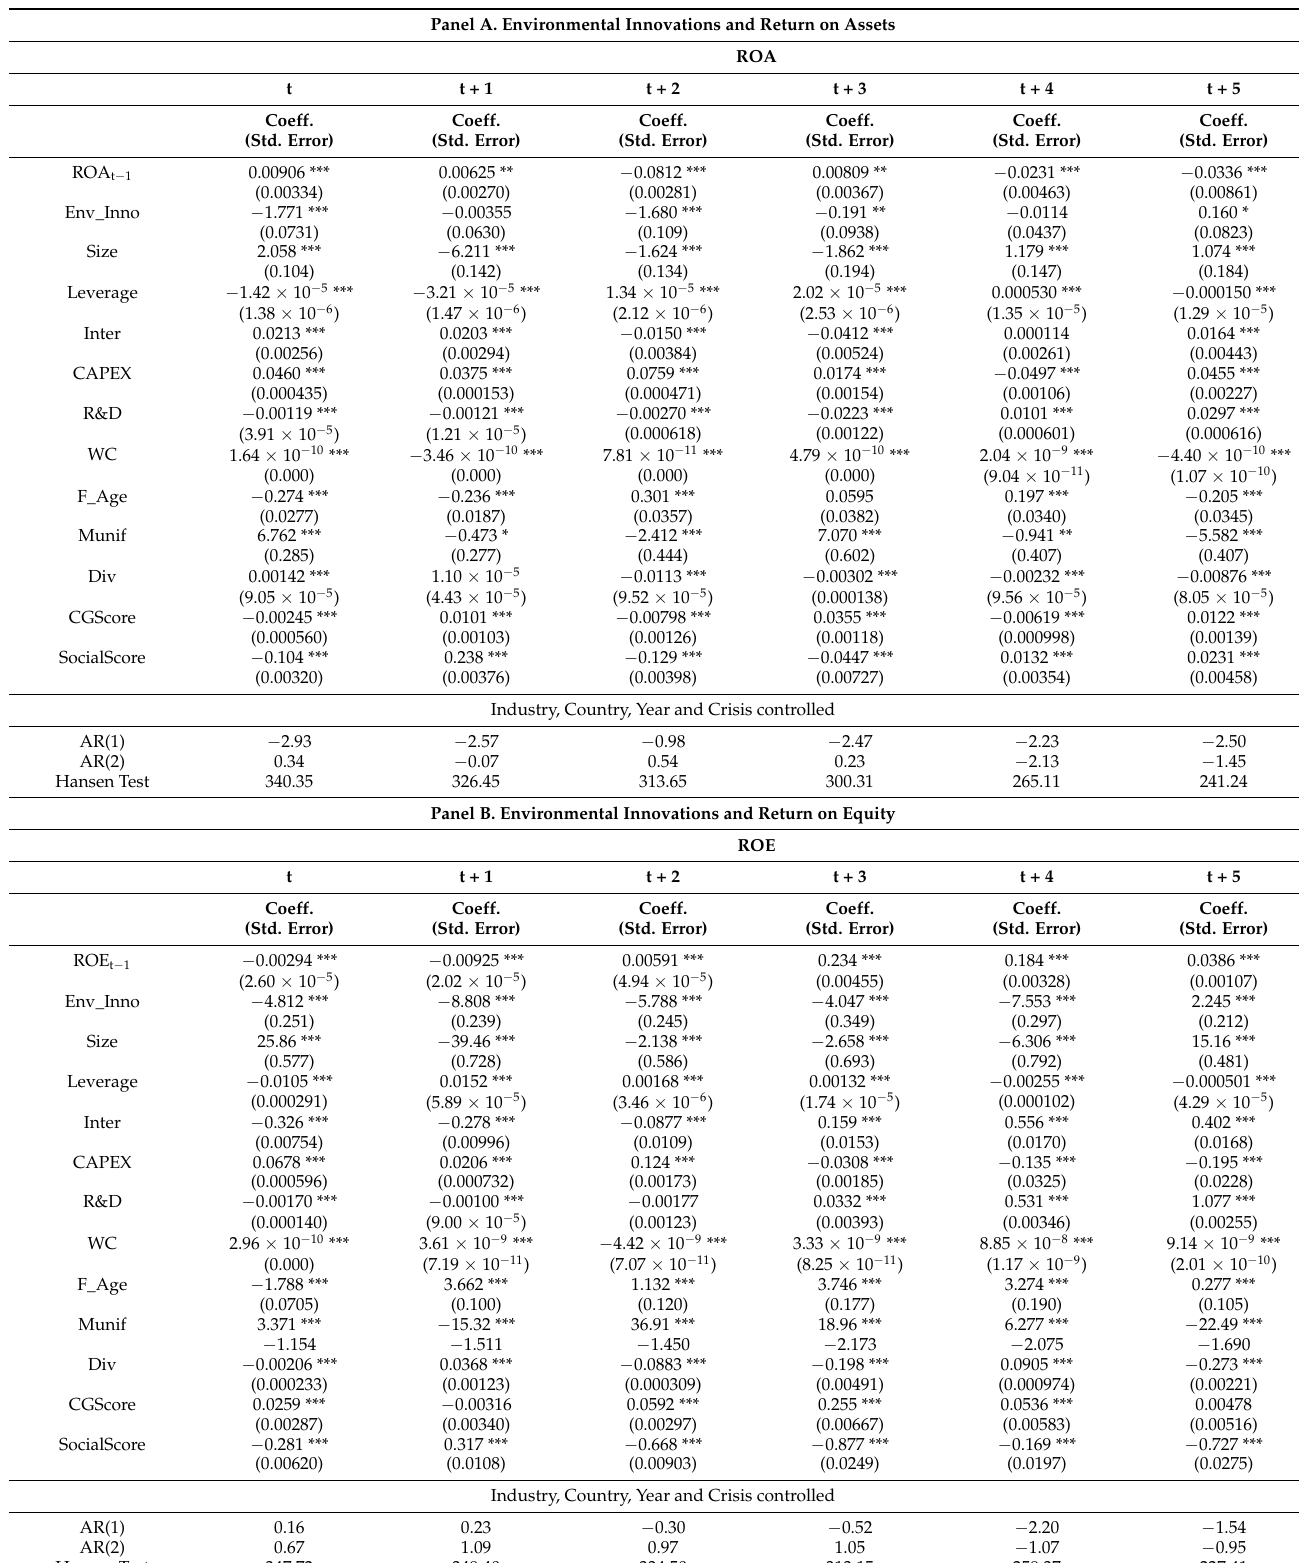
Table 4. Robustness analysis for profitability (*** p < 0.01, ** p < 0.05, * p < 0.1). Panel A. Environmental Innovations and Return on